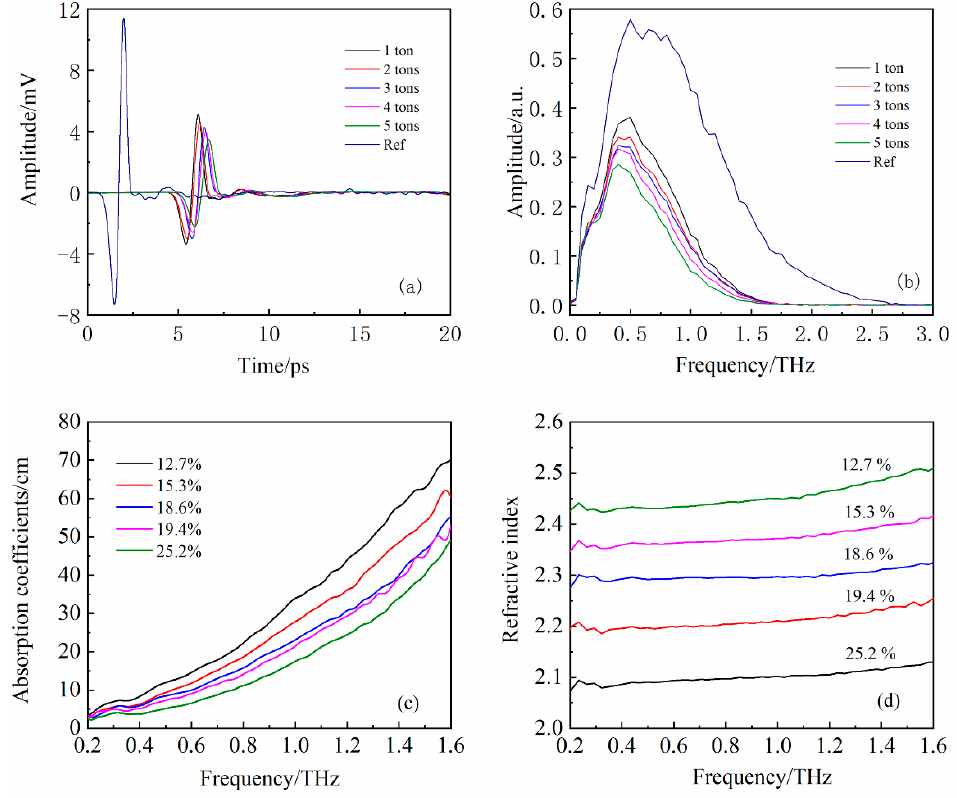
Figure 1. Terahertz time–domain spectra ( a ) and terahertz frequency–domain spectra ( b ) of tablets under various pressures. Frequency-dependent absorption coefficients ( c ) and refractive index ( d ) of tablets with various porosities.